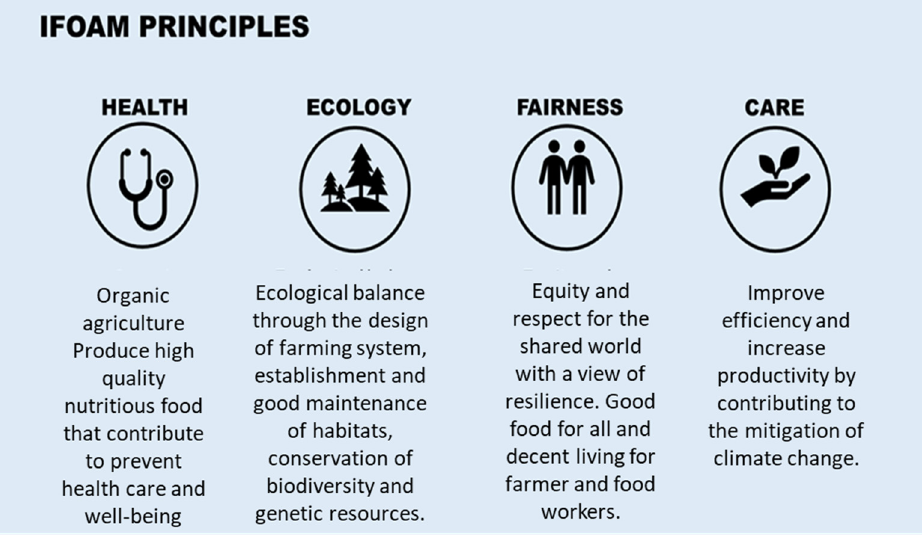
Figure 11. International Federation of Organic Agriculture Movements principles (modified by https://www.ifoam.bio/why-organic/shaping-agriculture/four-principles-organic, accessed on 27